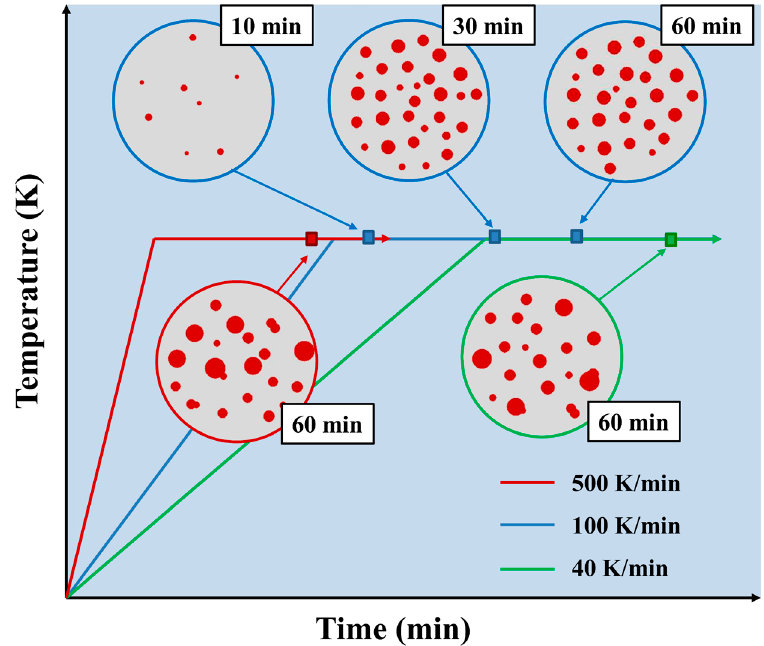
Figure 10. Schematic of the crystallization behavior of Fe 74.75 Si 8 B 10 P 3 C 2 Nb 1.5 Cu 0.75